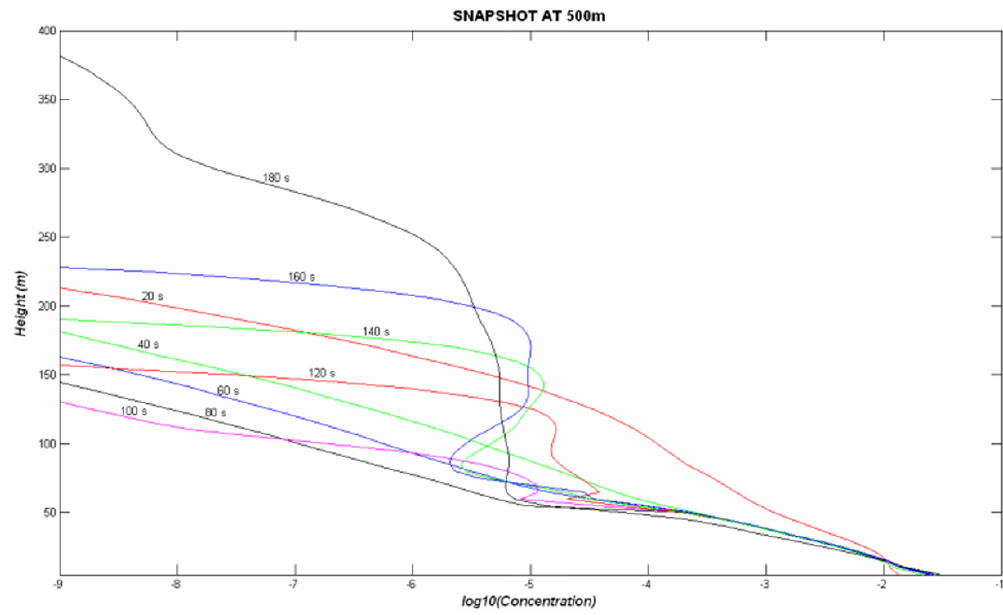
Fig. 4a. Temporal curves of solid particles logarithmic concentration as a function of height at 500m from the vent.